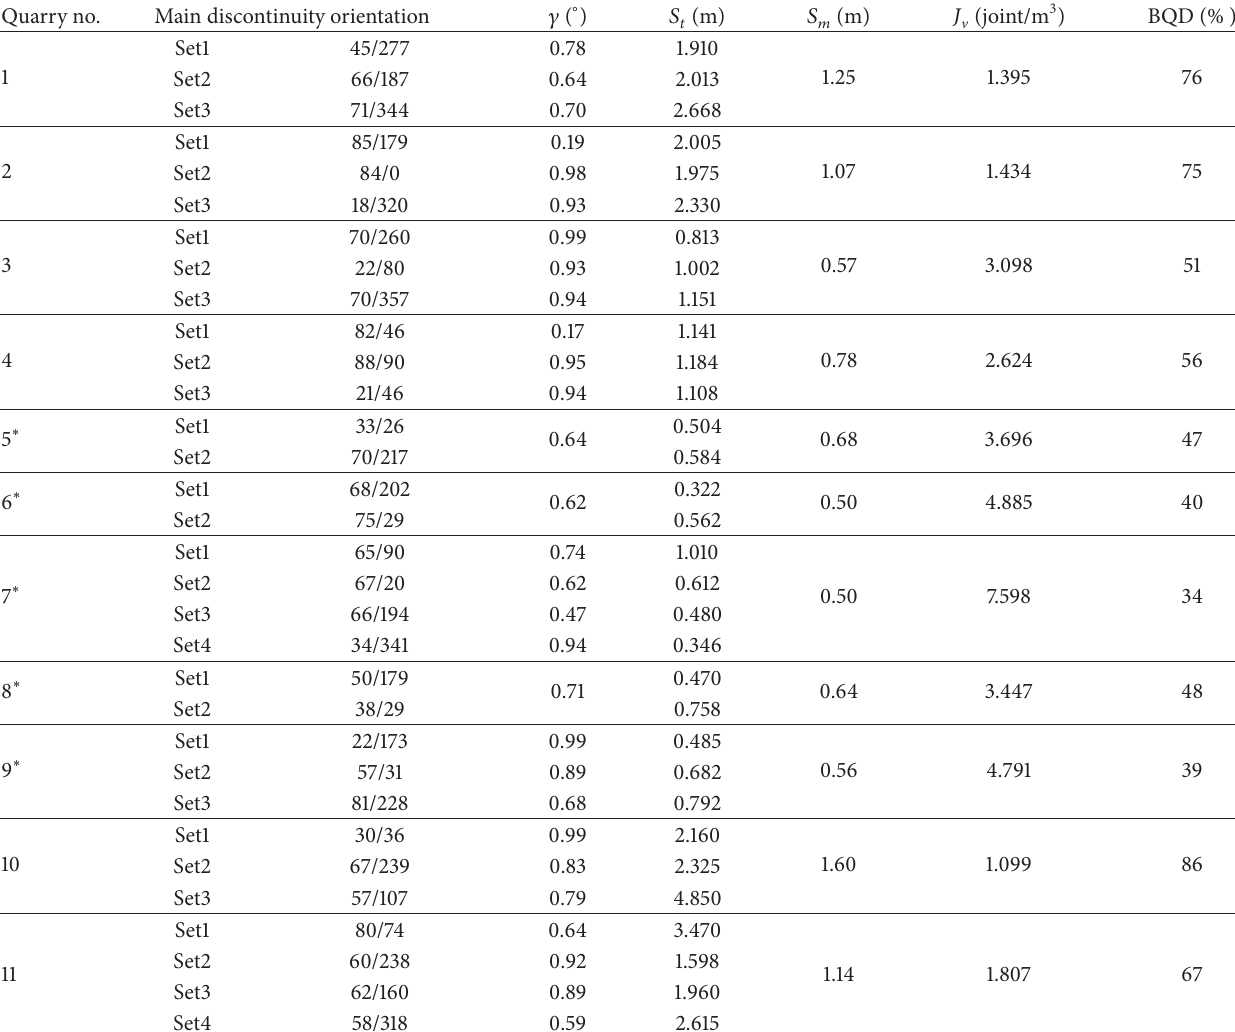
Table 1: General properties of the discontinuities of Karaburun limestone quarries. Quarry